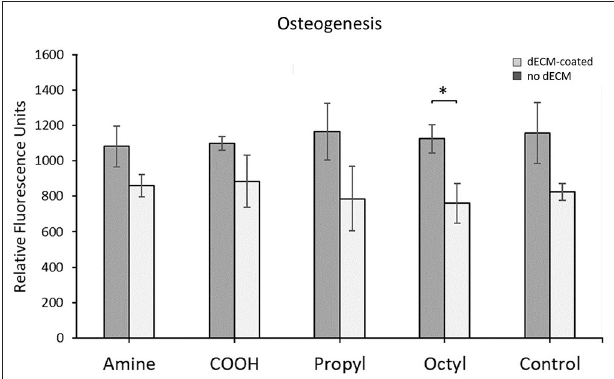
FIGURE 5 | Quantification of MSC osteogenesis when cultured on silanized surfaces with and without dECM. Brackets indicate significant differences, with * < 0.05. All means were statistically compared using a two-way ANOVA and a Tukey’s post-hoc test. However, only differences between a dECM-coated surface and its surface chemistry control are indicated for